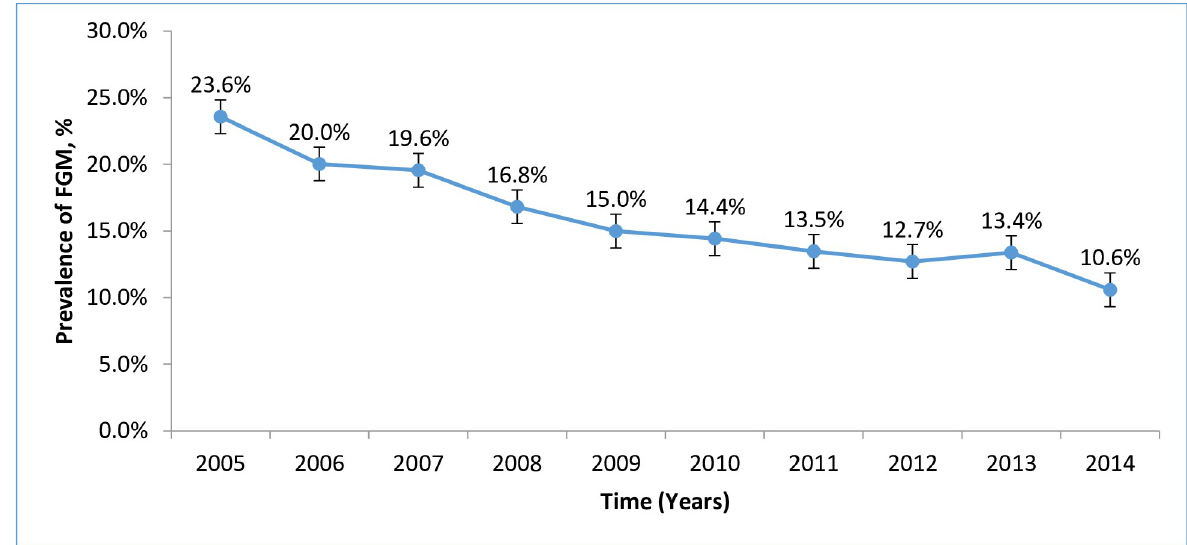
Fig 3. Trend in prevalence of female genital